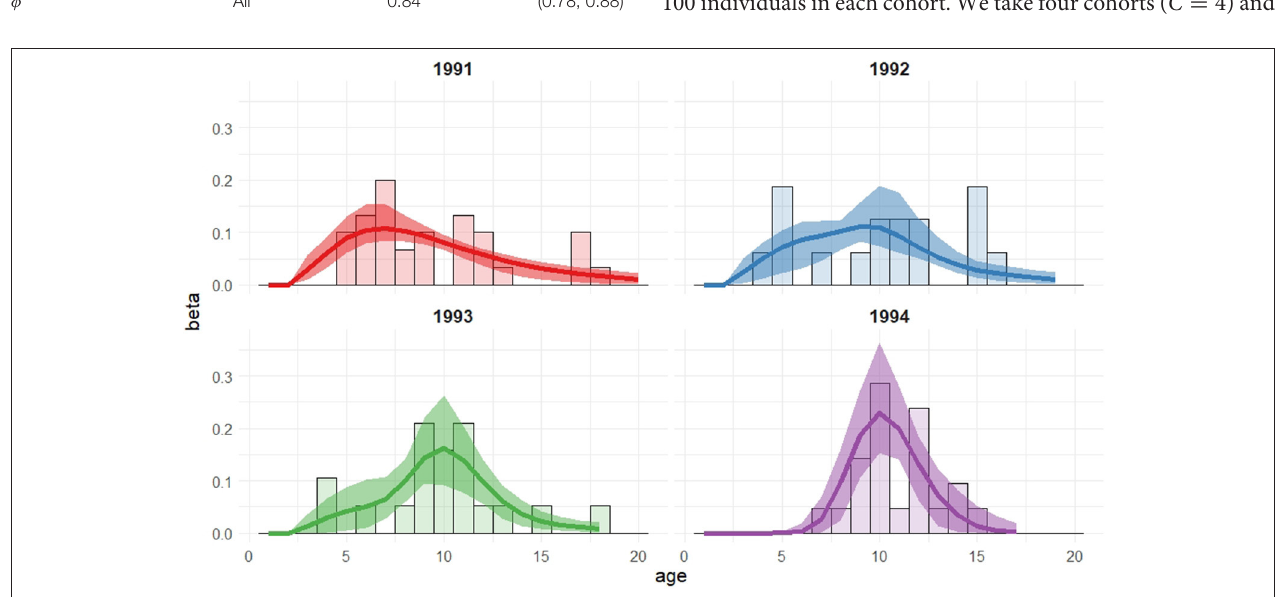
FIGURE 2 | Recruitment distributions, with 95% bootstrap confidence intervals, for the Isle of May gray seal study model with cohort dependent mixture proportions (two log-normal mixture).